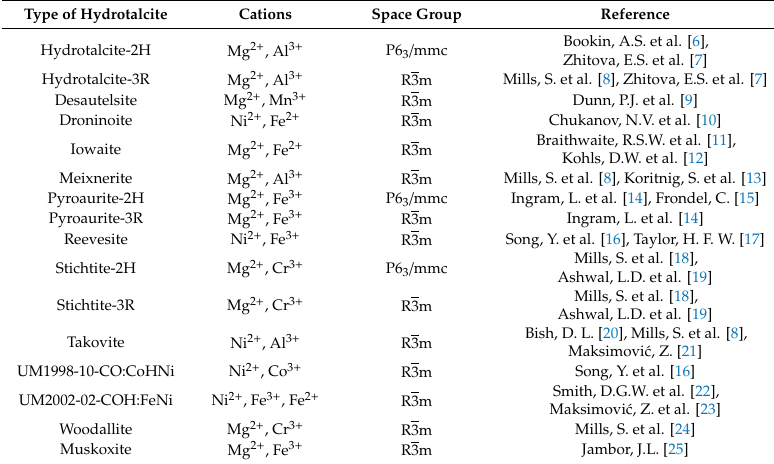
Table 1. Minerals of the hydrotalcite